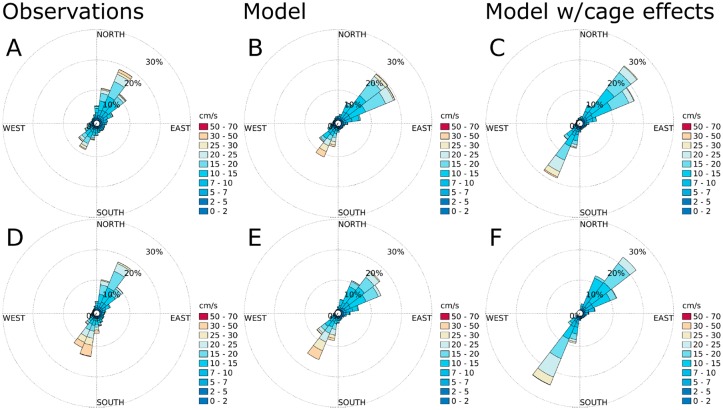
Current roses for the AWAC (Fig 5) at 10 m depth.A: observations for August-October, 2015. B: simulation results without cage effects for August-October, 2015. C: simulation results with cage effects for August-October, 2015. D: observations for May-June, 2016. E: simulation results without cage effects for May-June, 2016. F: simulation results with cage effects for May-June, 2016. The colors indicate current speed. Each sector spans 15°.